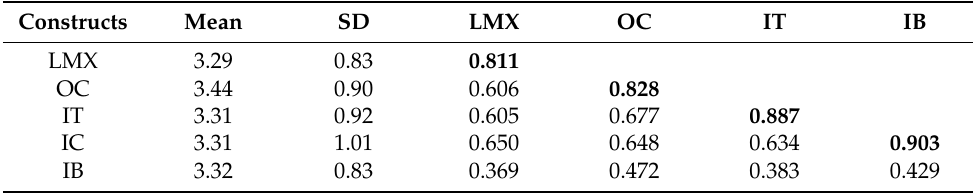
Table 3. Fornell–Larcker